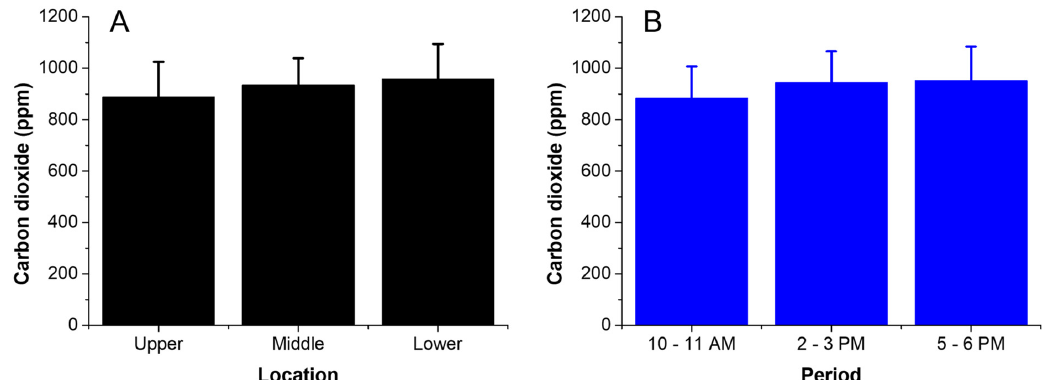
Figure 9. Data represent means and standard deviation (SD) of CO 2 concentration in the experi- mental greenhouse for location-wise CO 2 concentration variation ( A ) and period-wise CO 2 concentration variation ( B ).